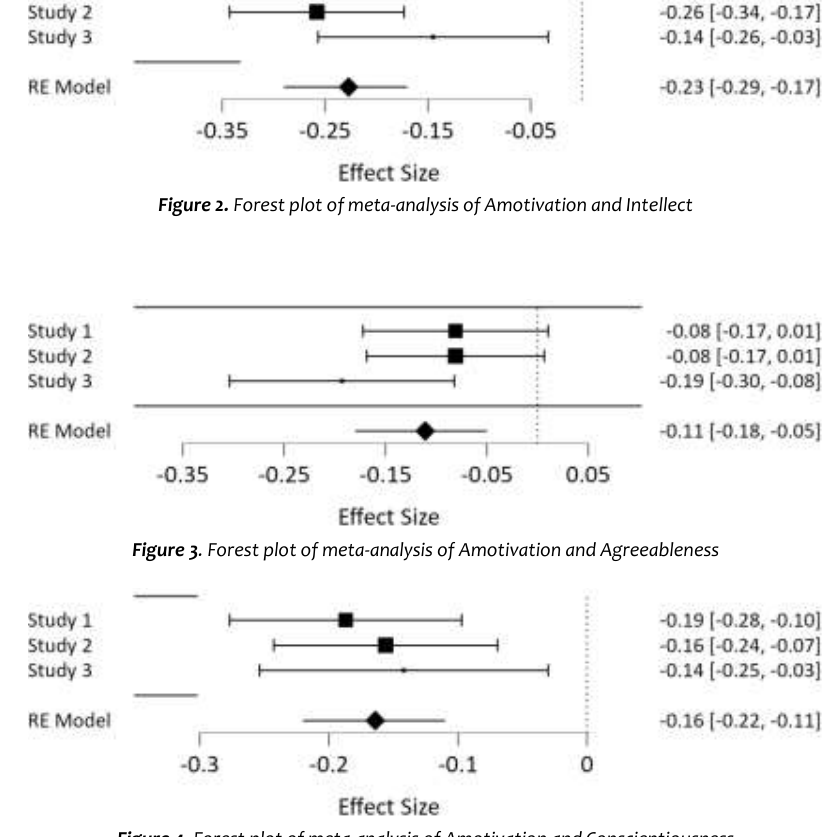
Figure 4. Forest plot of meta-analysis of Amotivation and Conscientiousness External regulation